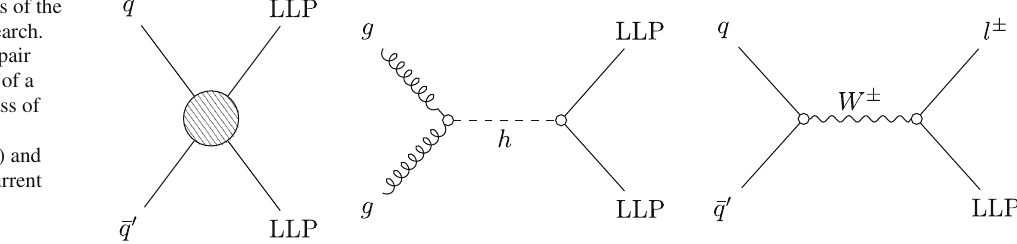
Fig. 1 Production modes of the LLP considered in this search. From left to right: direct pair production (DPP), decay of a SM-like Higgs with a mass of 125GeV/ c 2 produced by gluon-gluon fusion (HIG) and production by charged current (CC)